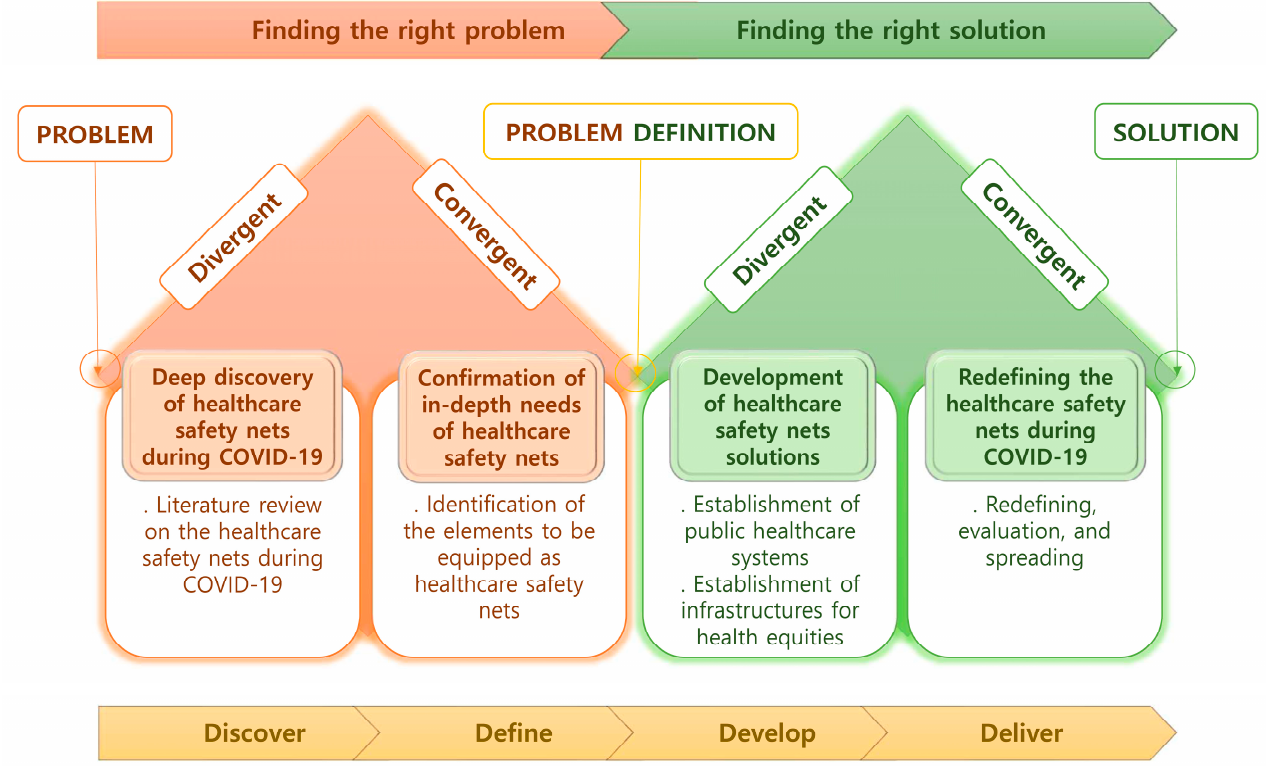
Figure 2. Conceptual framework of a healthcare safety net during the COVID-19 pandemic based on the double diamond model.